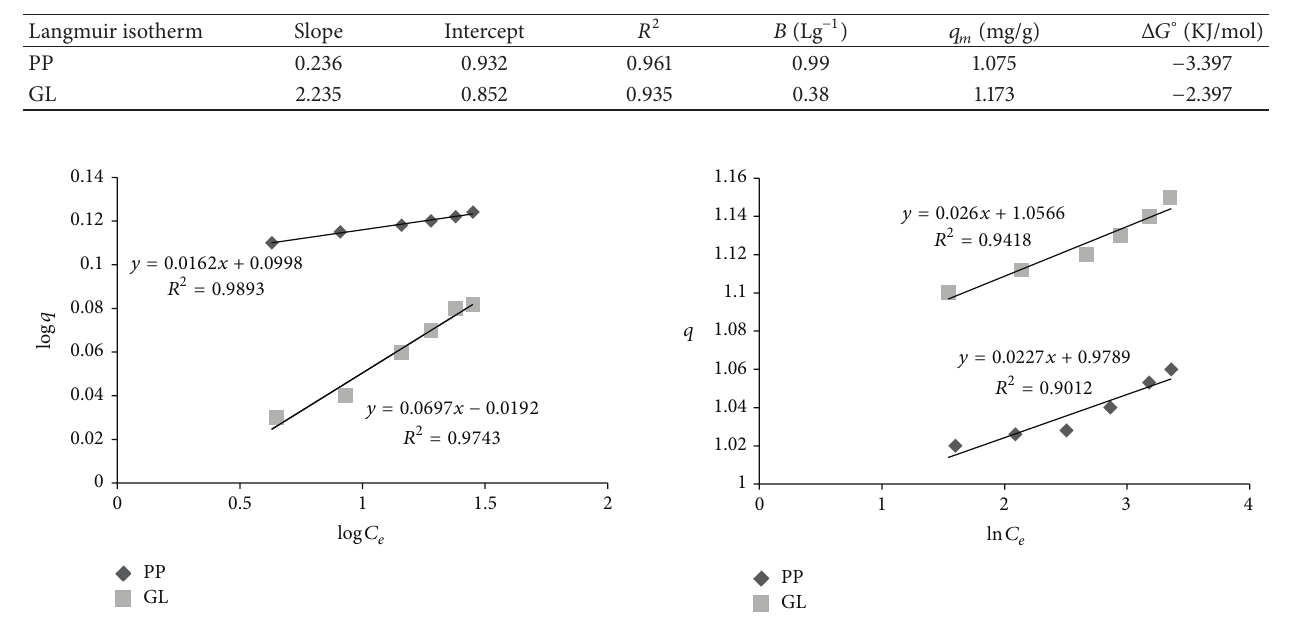
Table 6: Adsorption isothermal parameters of Langmuir isotherm.